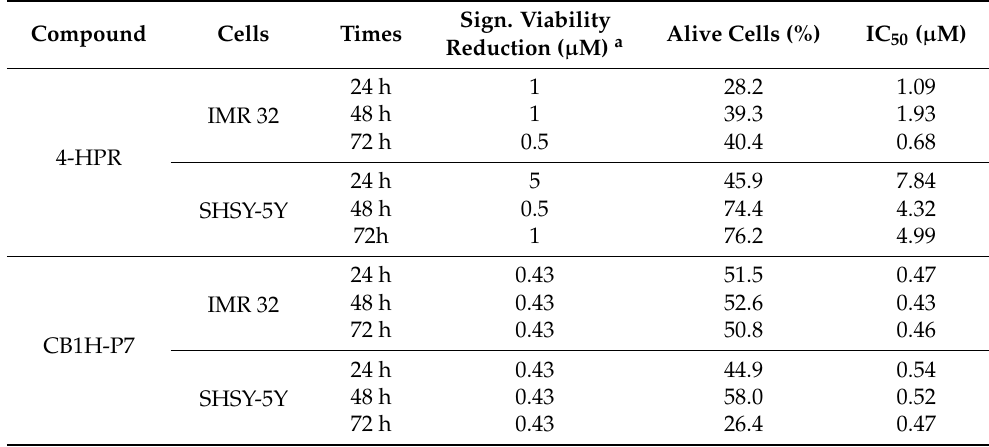
Table 3. Active concentrations (statistical significance p < 0.001), IC 50 values and residual viable cells (%) after treatment concerning CB1H-P7 NPs and